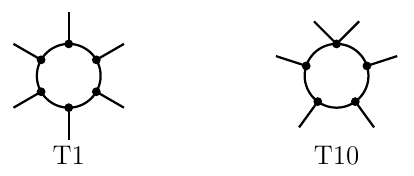
Figure 4 . Constructing topologies with 4-point vertices from existing topologies with only 3-point vertices by \shrinking" one connecting line. Here shown for the example how T1 generates T10. See also text.